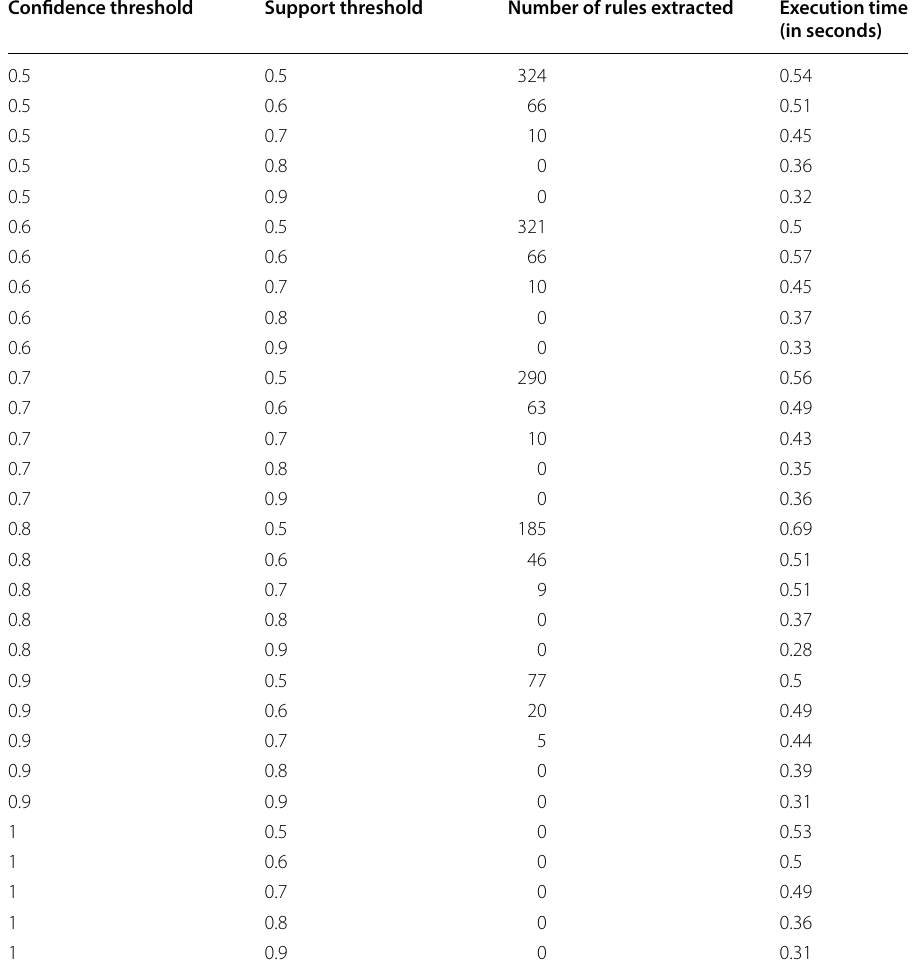
Table 2 Experimentation of several thresholds of confidence and support Confidence